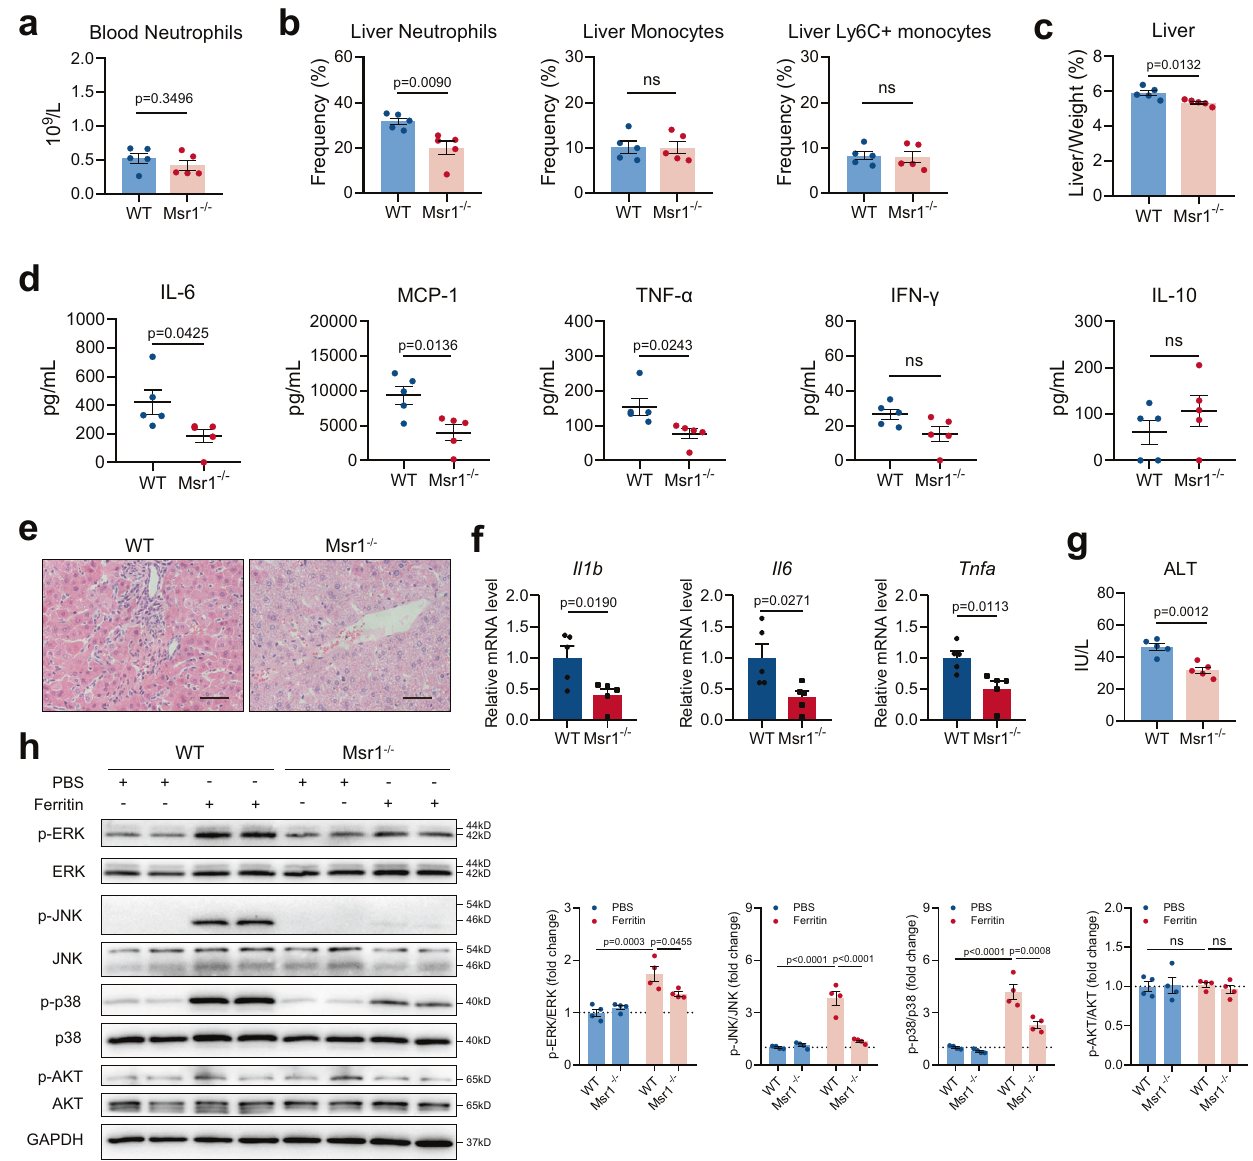
Fig.7|Msr1ablationamelioratesferritin-inducedin fl ammation.a – d Peripheral neutrophil numbers ( a ), hepatic myeloid in fi ltration ( b ), liver to body weight